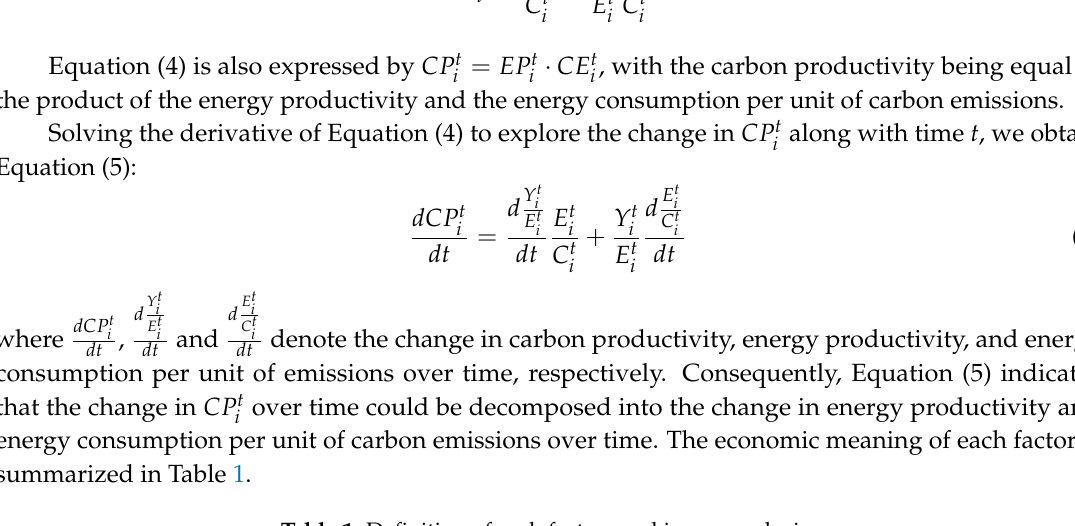
Table 1. Definition of each factor used in our